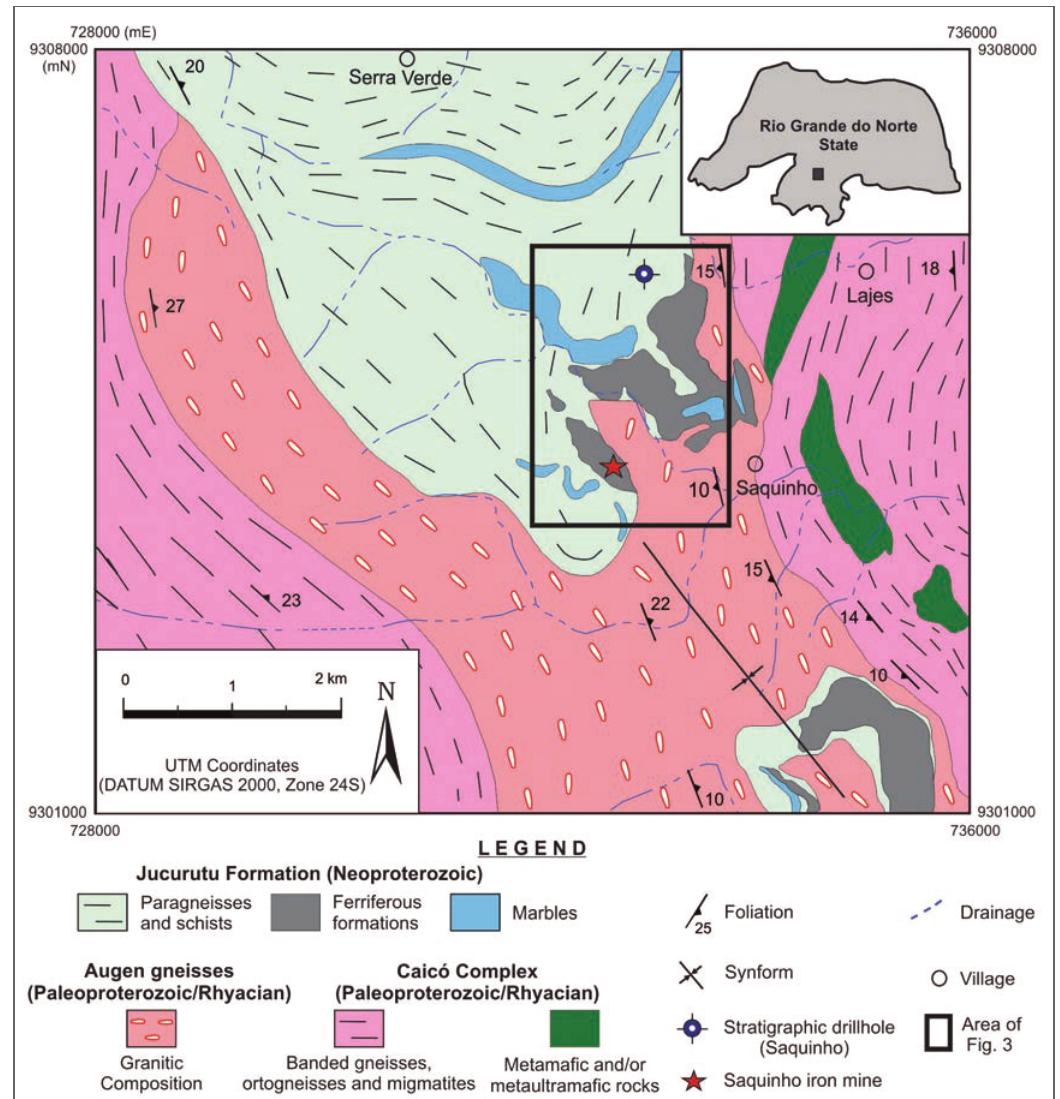
Figure 2 - Geological map of the Saquinho-Serra Verde region, adapted from Medeiros et al. (2012a).